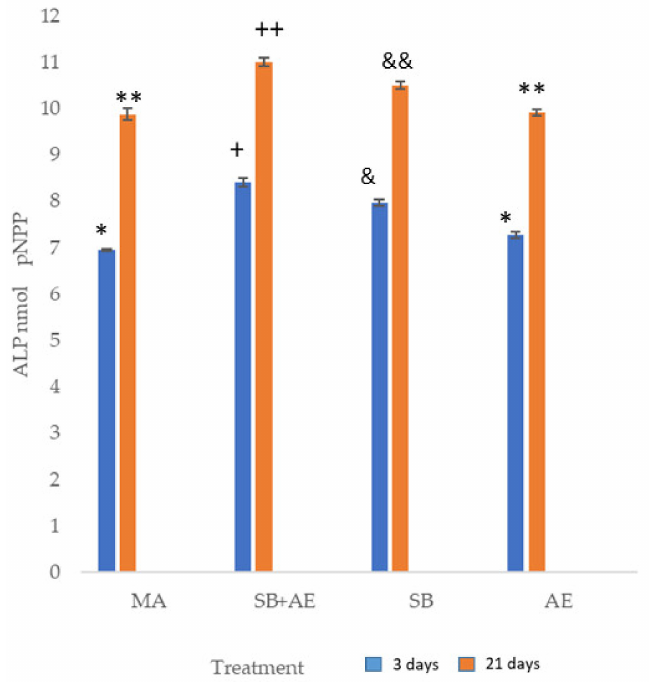
Figure 5. Alkaline phosphatase of SaOS-2 osteoblastic cells at 3 and 21 days for the different topogra- phies studied. Each symbol indicates the statistical differences’ significance p <